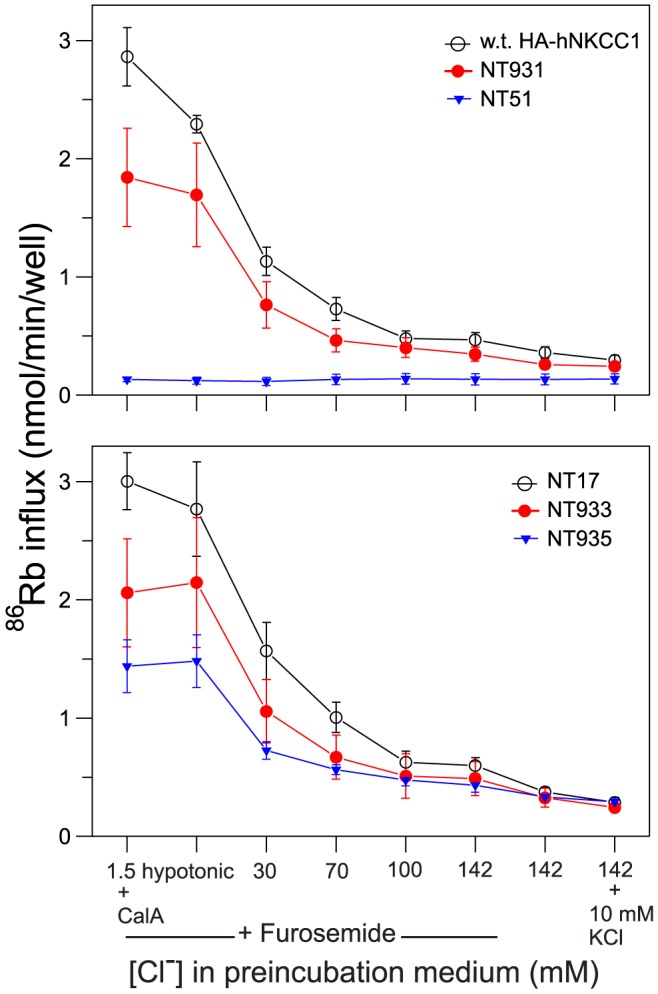
Activity of NKCC1 constructs upon activation in low Cl− media.
86Rb influx was determined in a 1-min 96-well plate influx assay after 45 min of preincubation of cells in various media as indicated. Data are shown for two constructs with wild-type hNKCC1 sequence (HA-hNKCC1, upper panel; NT17, lower panel), for hNKCC1 with threonines and serines mutated in the N-terminus phosphoregulatory domain (upper panel, NT51), and for three constructs with extracellular epitope tags (NT931, NT933, NT935). Furosemide is a rapidly reversible inhibitor included during pre-incubation to eliminate effects of NKCCs in that period, then removed prior to the flux. Calyculin-A (CalA) is a protein phosphatase-1 inhibitor added 15 min prior to the flux to achieve maximal phosphorylation and flux rate. Data are mean and S.E. from 3-6 experiments.